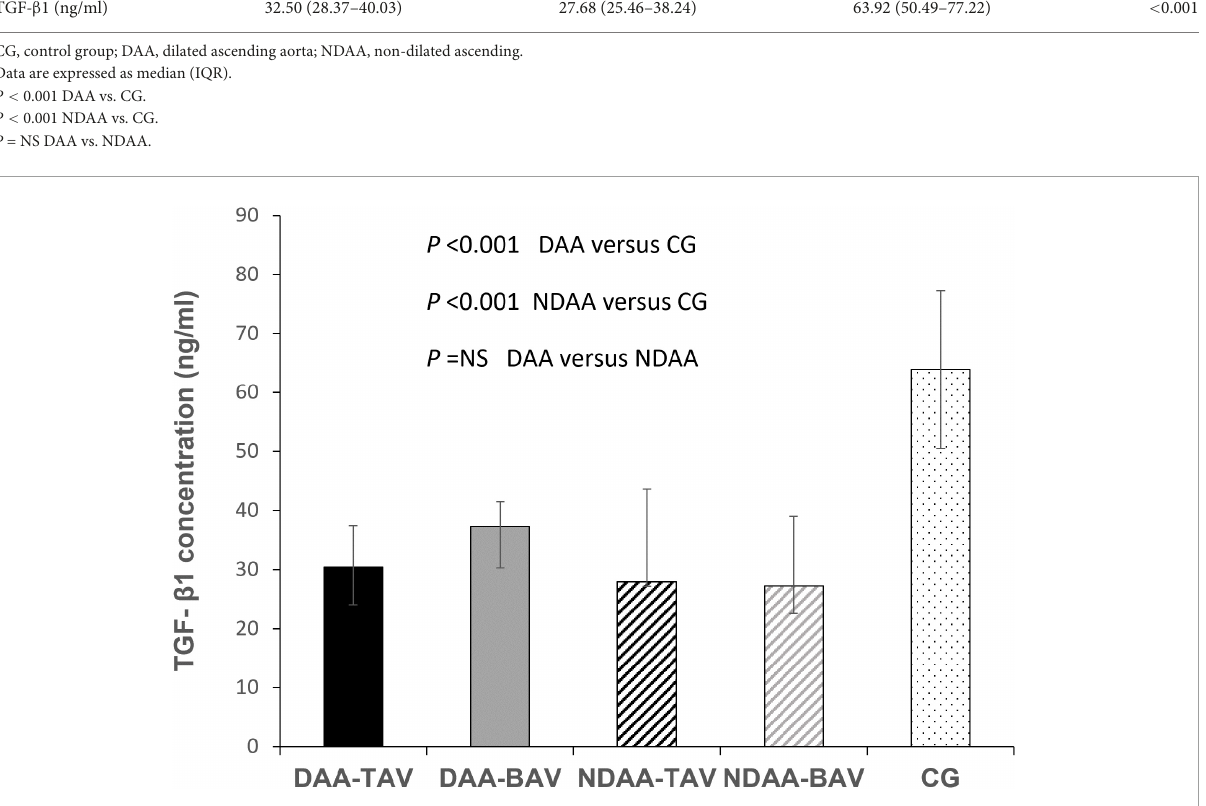
FIGURE1 TGF- β 1 concentrations in patients with dilated and non-dilated aortas according to aortic valve cuspidity. CG, control group; DAA-TAV, dilated ascending aorta- tricuspid aortic valve; DAA-BAV, dilated ascending aorta- bicuspid aortic valve; NDAA-TAV, non-dilated ascending aorta-tricuspid aortic valve; NDAA-BAV, non-dilated ascending aorta-bicuspid aortic